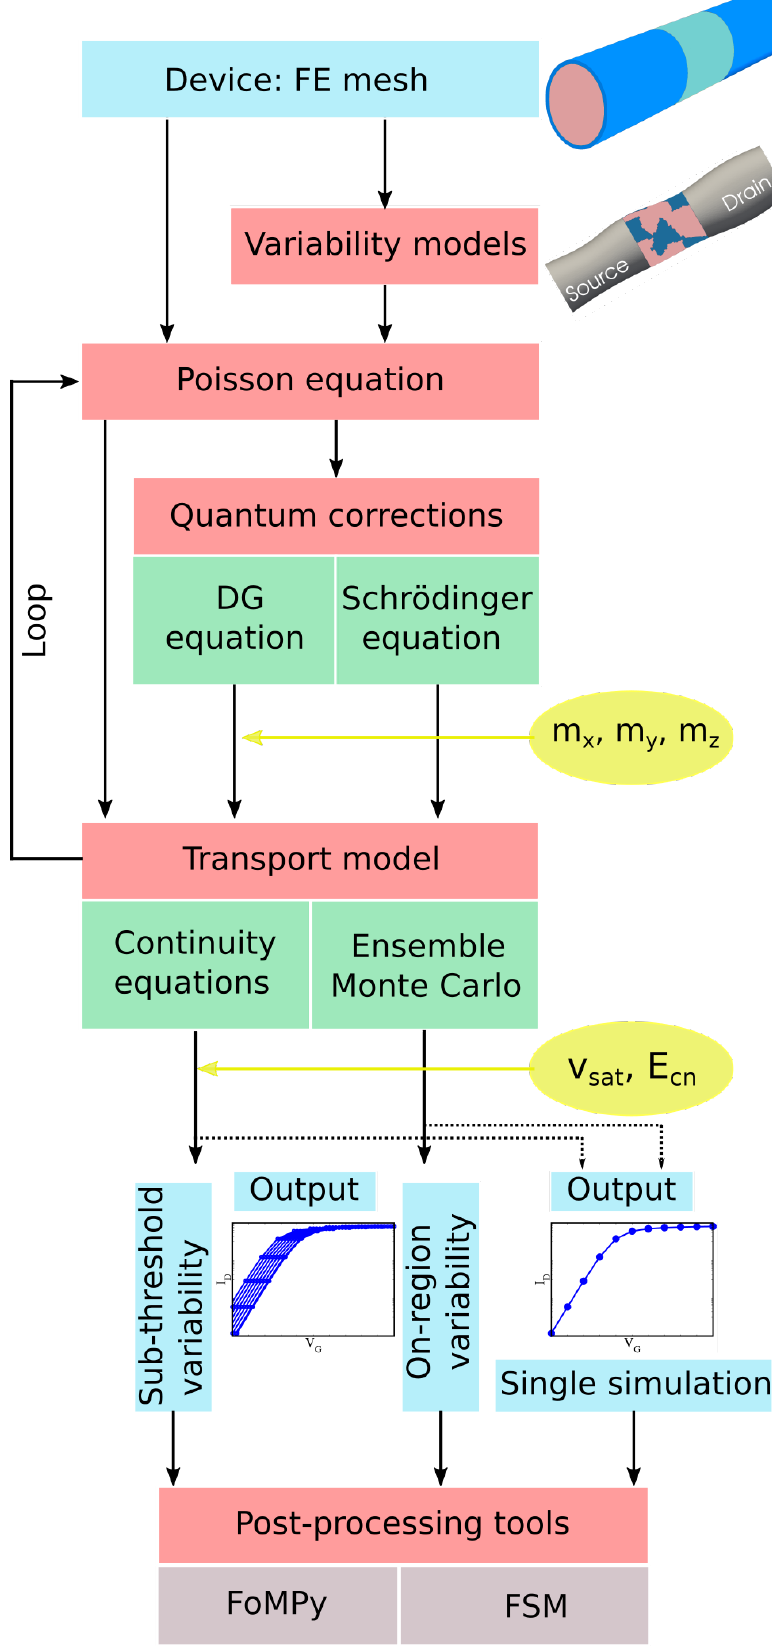
Figure 1. Basic flowchart of VENDES (Variability Enabled Nanometric DEvice